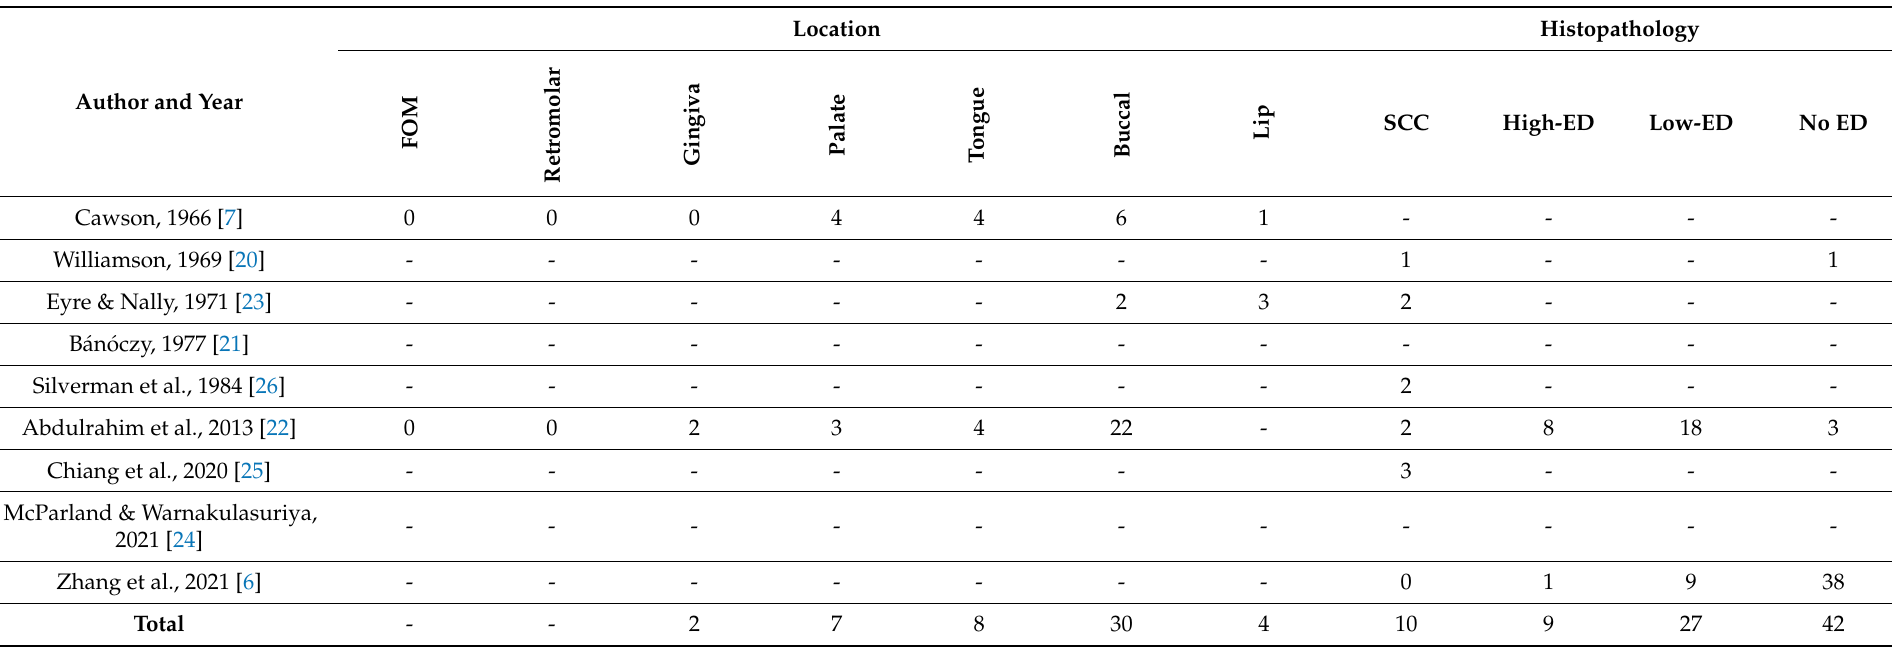
Table 2. Location of CHC lesions at the time of diagnosis (FOM: floor of the mouth; ED: epithelial dysplasia; CHC: chronic hyperplastic candidiasis; SCC: squamous cell